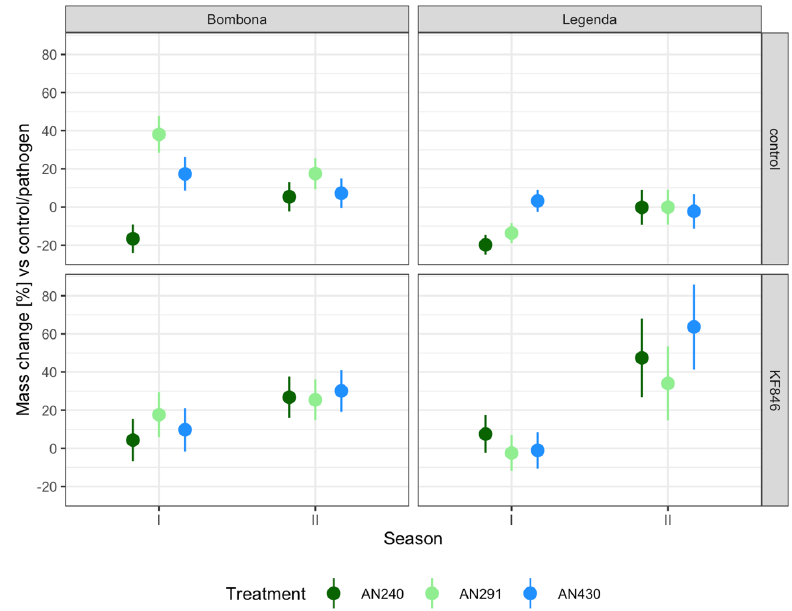
Figure 9. Yield mass changes in semi ‐ field experiments. Mass % increase/decrease scores.